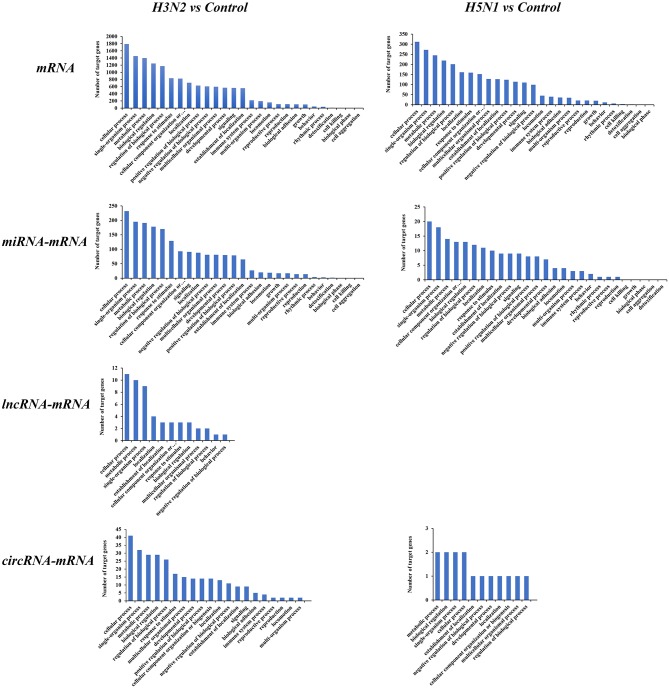
GO pathways of differentially expressed mRNAs and target genes of differentially expressed miRNAs, lncRNAs, and circRNAs. The horizontal axis shows the functional classification, and the vertical axis shows the number of genes in the classification.